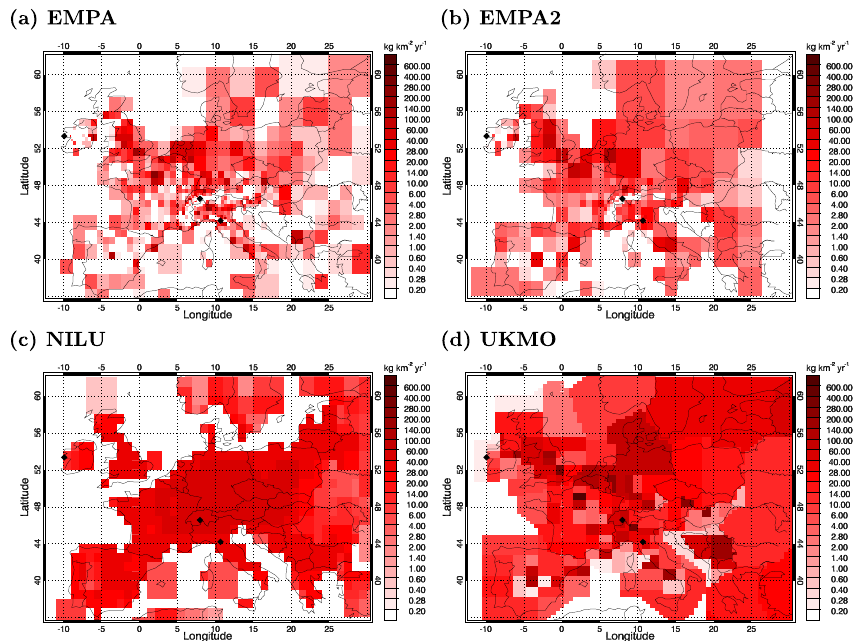
Figure 9. Uncertainty of prior HFC-134a emissions (experiment M2).